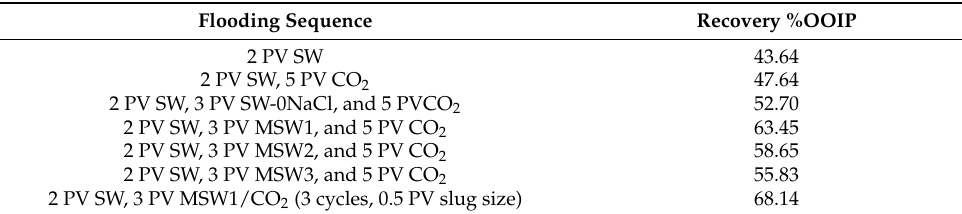
Table 5. Recovery factor of different flooding sequences